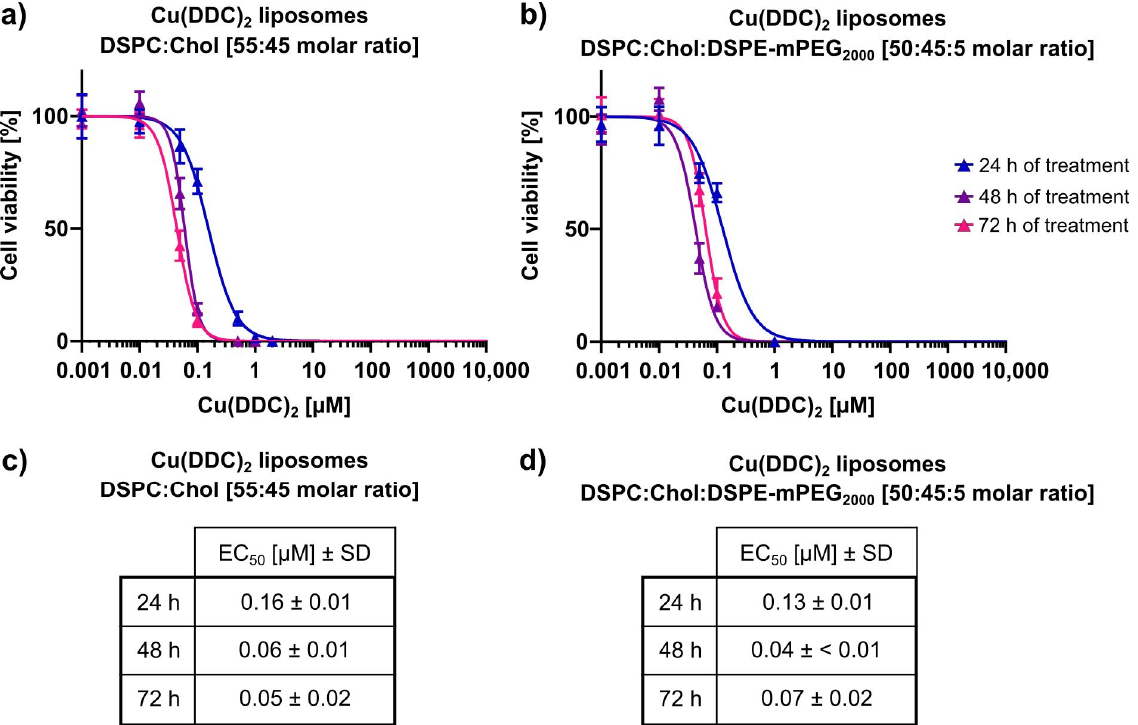
Figure 7. In vitro cytotoxicity of liposomal Cu(DDC) 2 on 2D LS monoculture cells. ( a , b ) LS monolayers were incubated with non-PEGylated ( a ) and PEGylated ( b ) Cu(DDC) 2 liposomes for 24, 48, and 72 h. Cell viability was analyzed using the 2D CellTiter-Glo ® assay after indicated treatment duration. ( c , d ) EC 50 values after 24, 48, and 72 h of treatment with non-PEGylated ( c ) and PEGylated ( d ) Cu(DDC) 2 liposomes. Data are expressed as the mean ± SD ( n = 3–7).